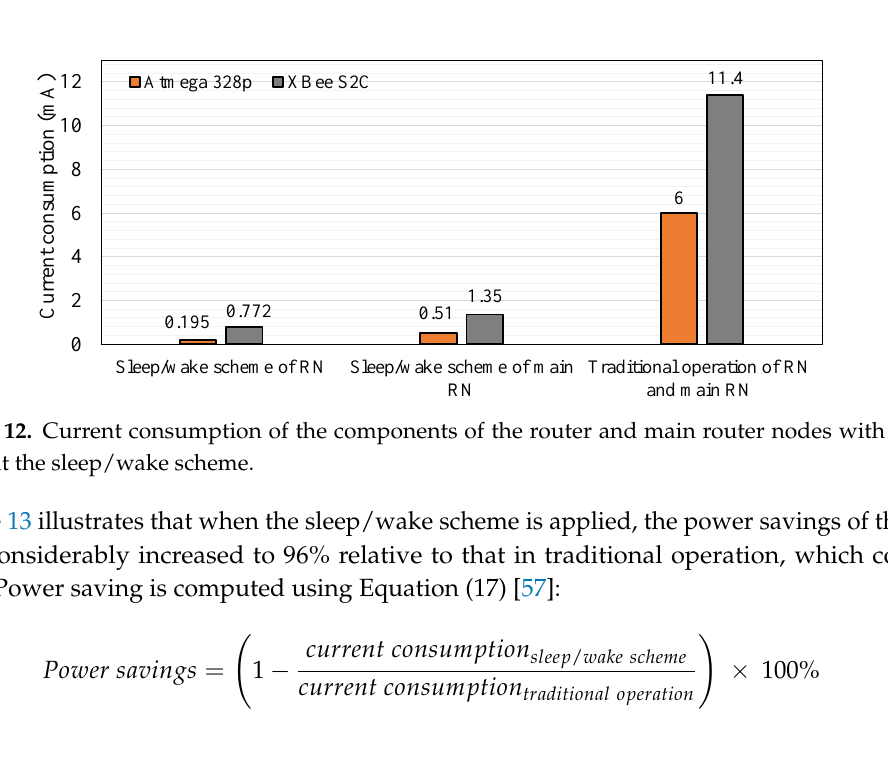
Figure 13. Developed power savings of the WSN nodes based on the sleep/wake scheme. In addition, power savings are improved to 90%, 99%, 98%, and 95% for soil moisture, DHT11, Atmega 328p, and XBee S2C relative to their values in traditional operation, respectively. Power savings are increased to 94% and 89% for the router and main router nodes, respectively (Figure 13), relative to traditional operation (i.e., without the sleep/wake scheme), which consumes 17.4 mA for the router and main router nodes. Power savings are computed using Equation (17). Figure 13 shows that the power savings of the sensor node are better than those of the router and main router nodes for the same reasons mentioned previously. The power saving of the router node is 96.7% and 93% for Atmega 328p and XBee S2C relative to traditional operation, respectively. The power saving of the main router is 91.5% and 88% for Atmega 328p and XBee S2C relative to traditional operation, respectively. 9.3. Battery Life Estimation Based on the Sleep/Wake Scheme The application of the sleep/wake scheme verifies that this approach can improve the power consumption of the proposed WAS to 0.731 (sensor node), 0.967 (router node), and 1.86 mA (main router node). Consequently, battery life can be extended to 148 (sensor node), 112 (router node), and 58 (main router node) days by using two rechargeable Li-ion battery with 7.4 V/2600 mAh. The battery life of the sensor node and the router/ main router nodes is 5.6 days and 6 days in the